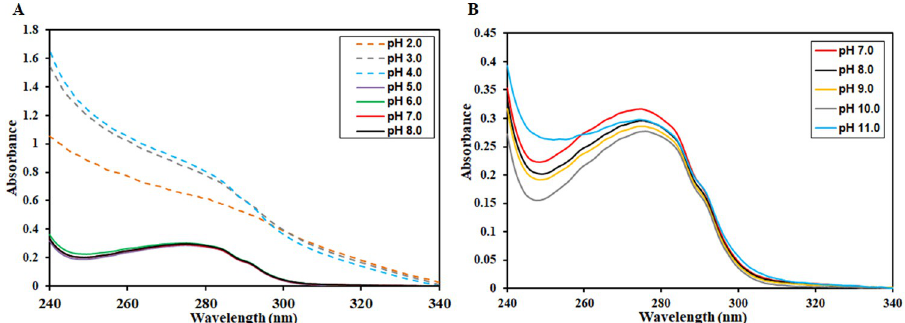
Fig 3. Showing pH-induced changes in the tertiary structure of CDK6 were investigated by absorbance spectroscopy at 25˚C. (A) Absorption spectra of CDK6 in the pH range of 2.0 to 8.0. (B) Absorption spectra of CDK6 in the pH range of 7.0 to